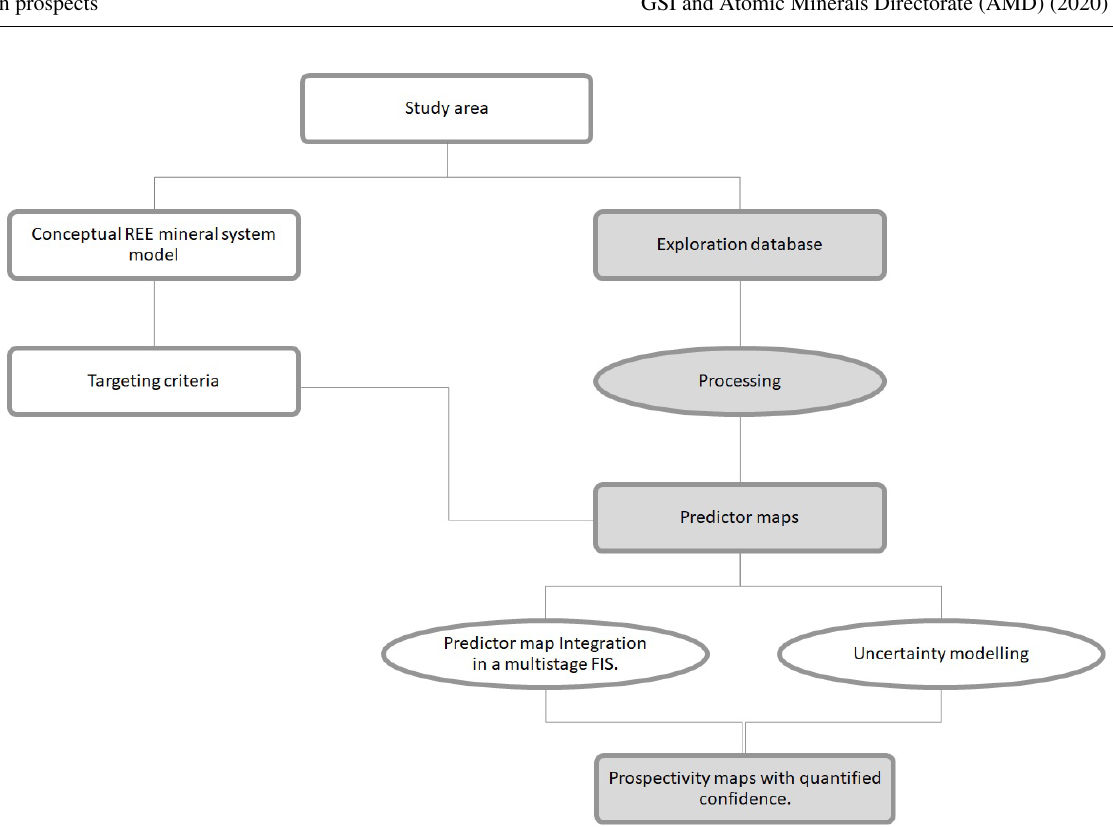
Figure 2. Flow chart depicting the methodology. Rectangular boxes contain generated objects, and oval boxes contain processes used for creating the objects. Shaded boxes indicate the objects and processes created and implemented in a GIS,